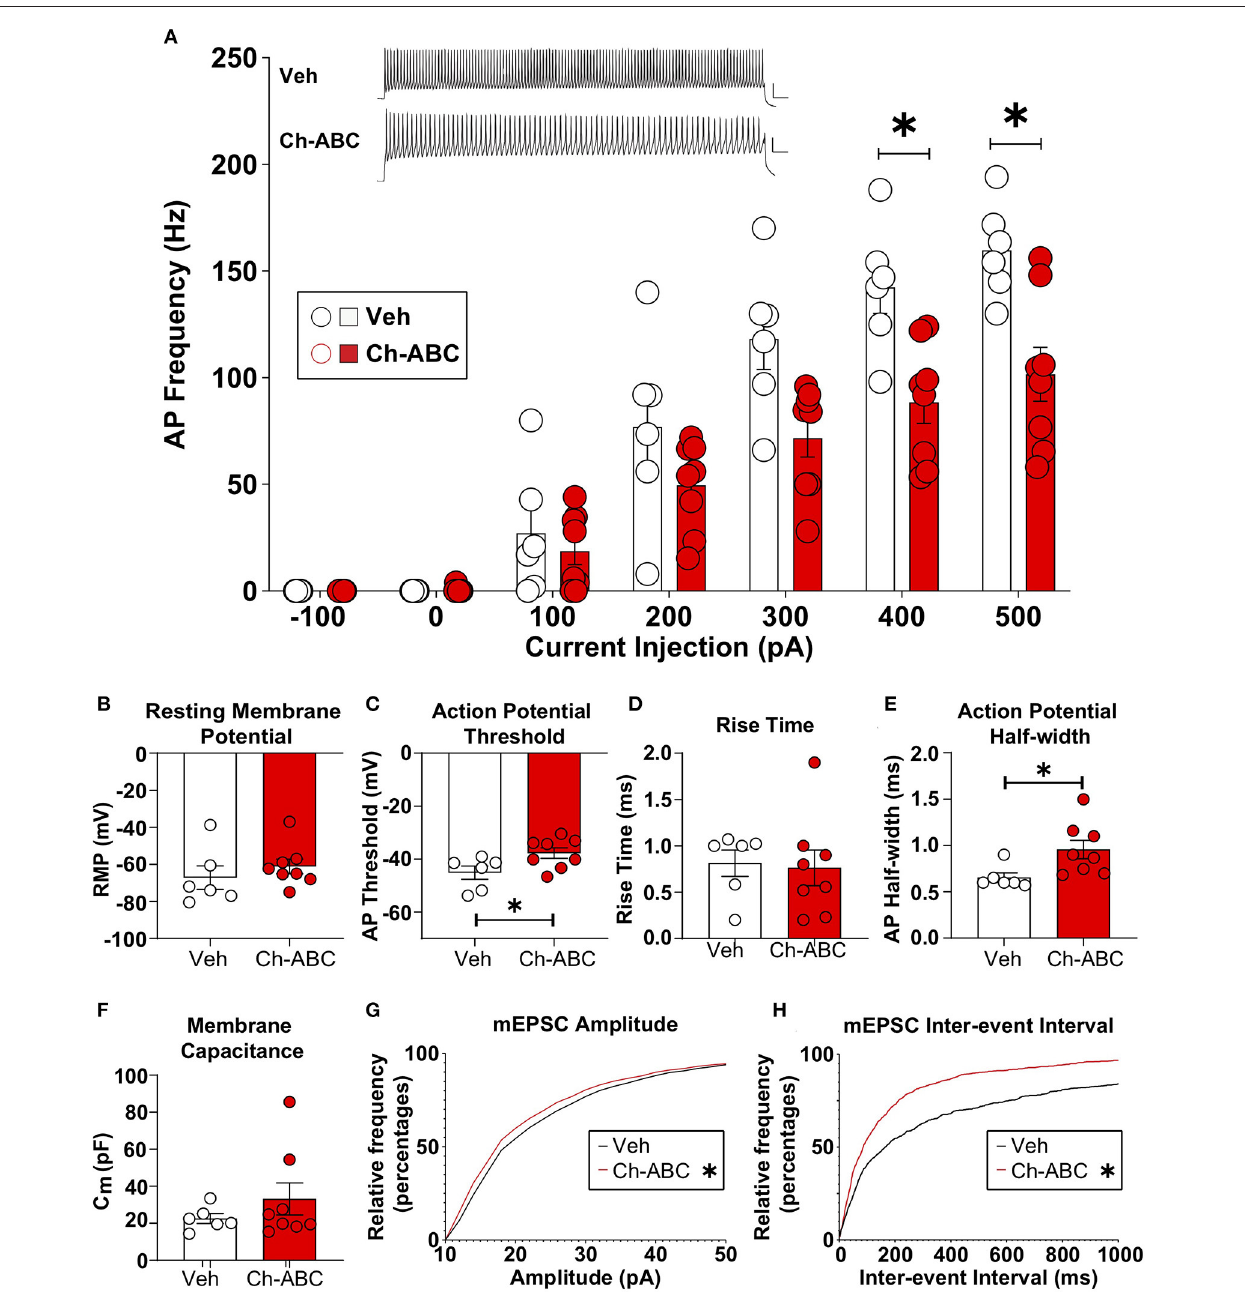
FIGURE 4 | Ch-ABC treatment prior to cocaine-primed reinstatement decreases the firing rate of PNN surrounded FSIs within the prelimbic PFC and changes mEPSC frequency and amplitude onto FSIs. (A) Decrease in average frequency of action potentials across range of current injections; shown are representative traces of action potentials evoked by 500pA current injection. Scale bars represents 20ms, 20mV; (B) Resting membrane potential; (C) Decrease in action potential threshold; (D) Rise time; (E) Increase in action potential half-width; (F) Membrane capacitance; (A–F) : Vehicle, n = 6 rats, Ch-ABC = 8 rats. (G) Decrease in mEPSC amplitude; (H) Increase in mEPSC frequency; Data are mean ± SEM (bars) with individual cells (circles). (G,H) : Vehicle n = 4 rats, Ch-ABC n = 5 rats; Mann-Whitney, *P < 0.05.